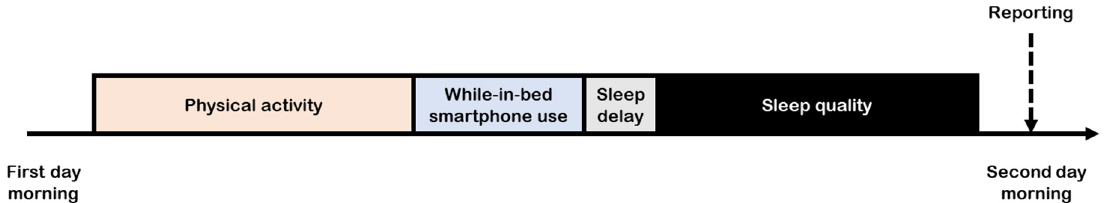
Figure 1. The time sequence of the investigated